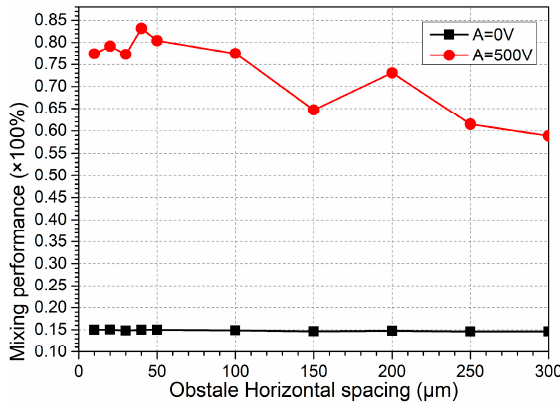
Figure 8. A numerical study of the influence of the horizontal distance between adjacent opposing blocks on the mixing performance.